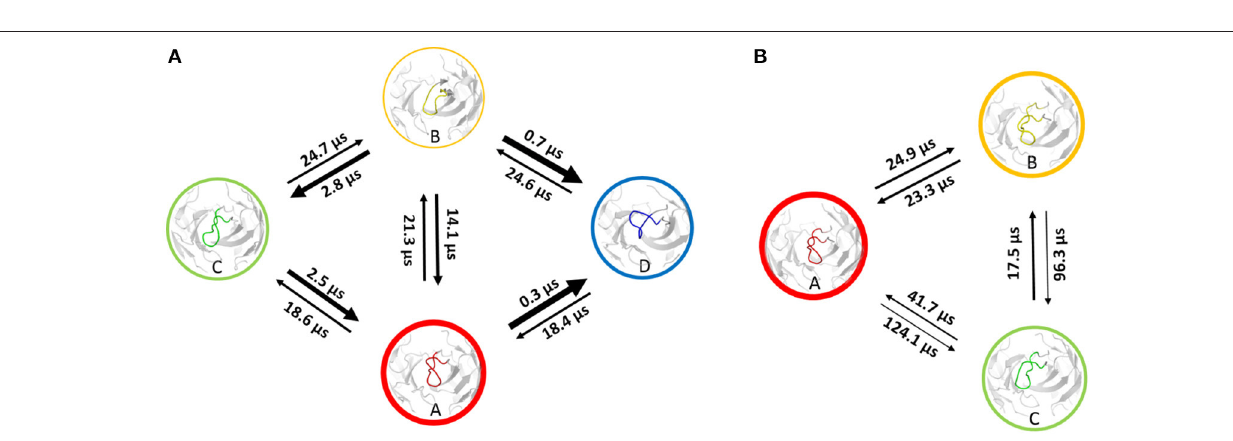
Frontiers in Immunology |